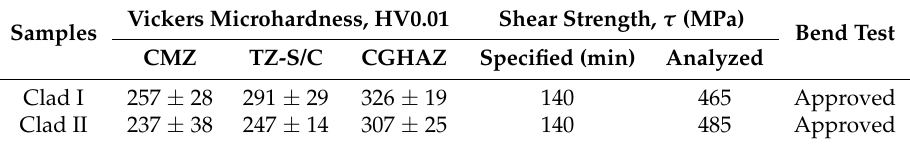
Figure 16. Vickers microhardness maps obtained with 0.01 kgf (HV0.01) in the transition zones of substrate/clad of clads I ( a ) and II ( b ): 9%Ni steel pipes cladded with one and two layers of Ni-based superalloy 625 by gas tungsten arc welding with a hot wire, where the values of zero in the axes of the ordinates correspond to the fusion line and the negative values to the substrate. Table 5. Mean Vickers microhardness (HV0.01) of the complete mixed zone (CMZ), transition zone of substrate/clad (TZ-S/C), and coarse grain heat affected zone (CGHAZ) of clad I and II (1st and 2nd layers), as well as the specified (ASTM A265-12) and analyzed shear strengths and the results of bend tests performed on clad I and II (Figure 1).